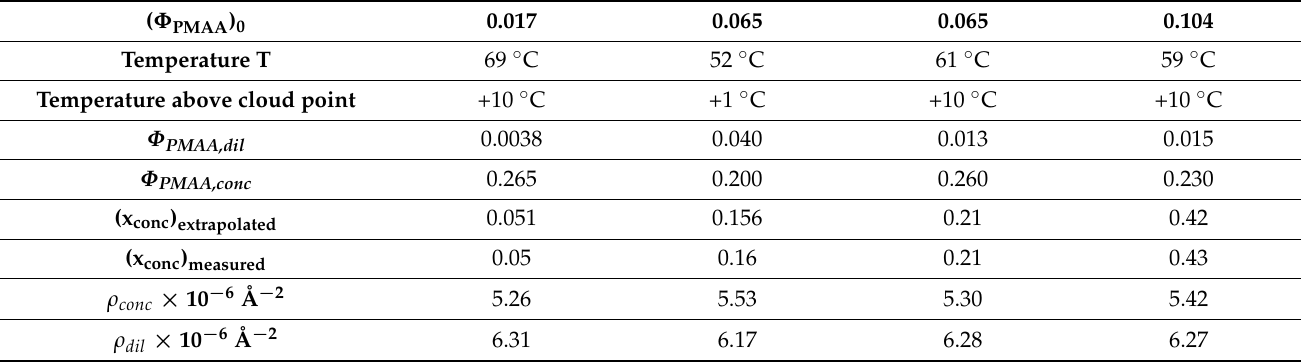
Table 2. Volume fraction of PMAA in each phase above the cloud point for different PMAA concen- trations and different temperatures. ( Φ PMAA ) 0 stands for the initial PMAA volume fraction while Φ PMAA , dil and Φ PMAA , conc are the volume fraction in the dilute and concentrated phase. (x conc ) measured is equal to the ratio between the volume of the concentrated phase and the total volume of the sample. The scattering length densities ( ρ dil and ρ conc ) of both dilute and concentrated phases were calculated on the basis of Φ PMAA , dil and Φ PMAA , conc